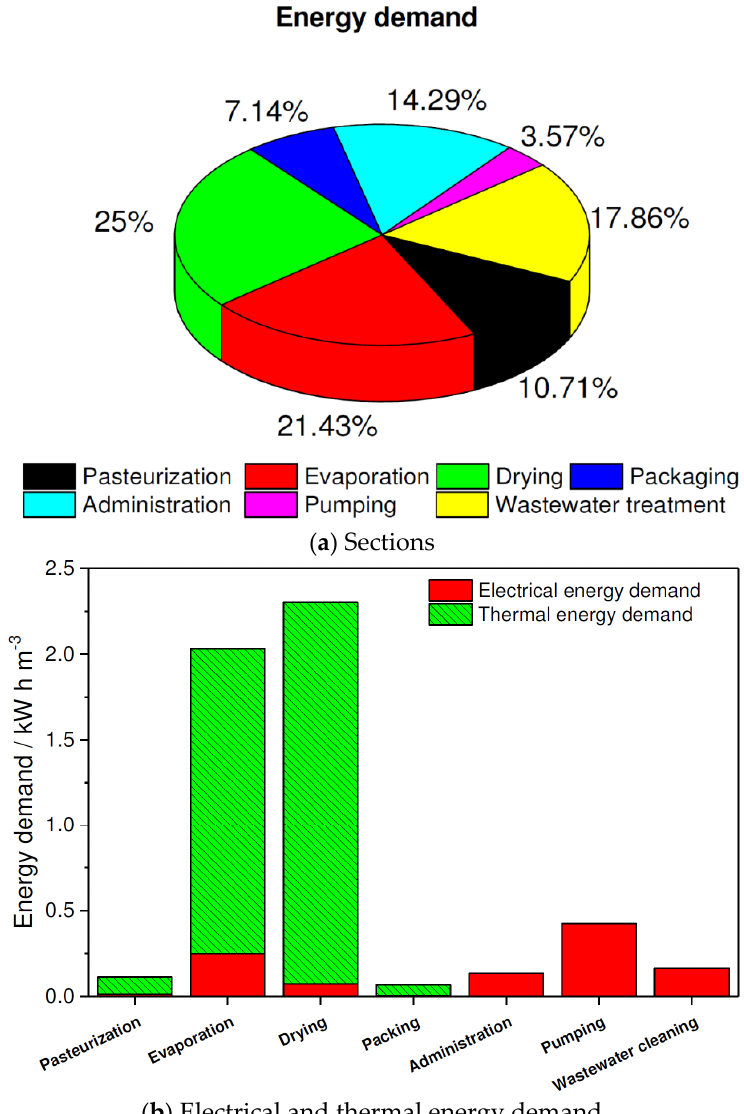
Figure 4. Energy consumption in powdered milk production.